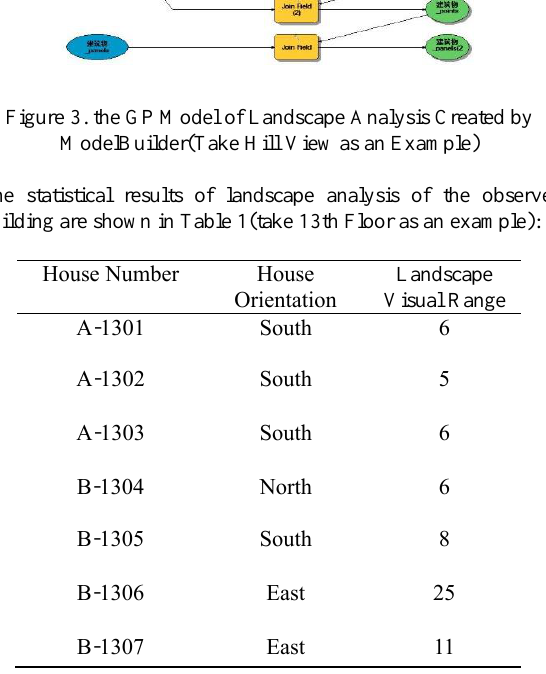
Table 1. the Statistical Results of Building Landscape Analysis The 3D visualization effect drawing shown in Figure 5 is got by classification rendering of rectangular panels of the building according to the landscape visual range of the corresponding points, and the gradient colours from green to red represent the landscape range from small to large.